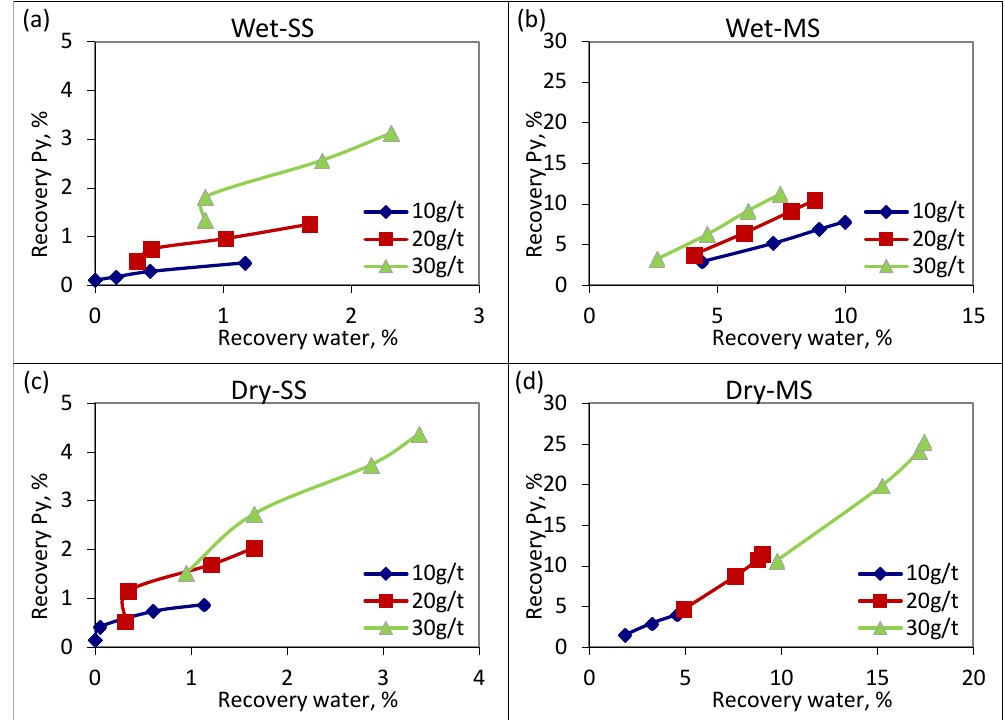
Figure 8. Pyrite vs. water recovery in flotation after milling conditions of ( a ) Wet-SS ( b ) Wet-MS ( c ) Dry-SS ( d ) Dry-MS.